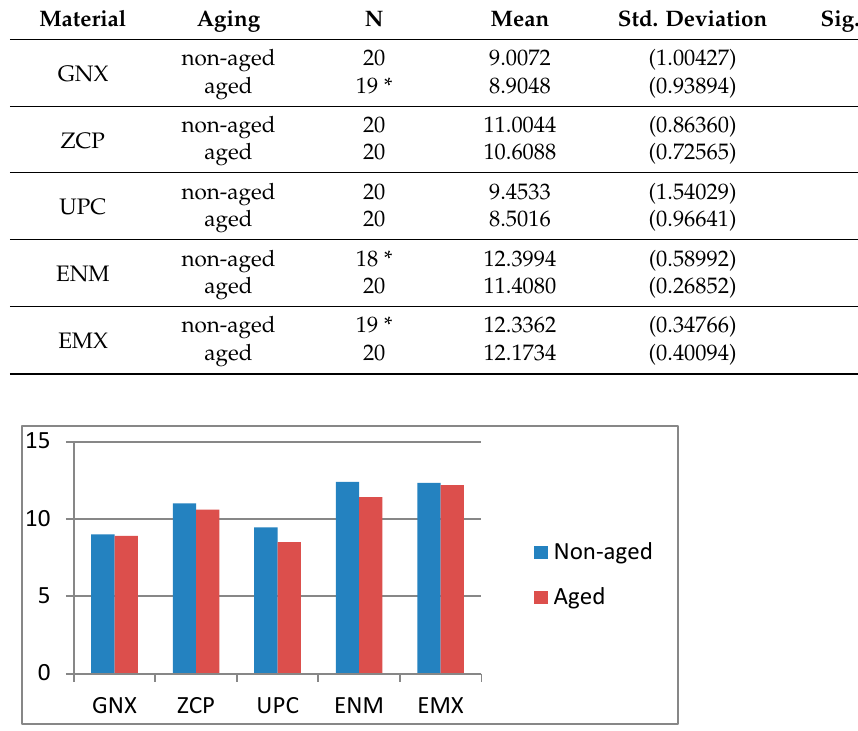
Figure 6. OP values of materials within same material group; non-aged and aged.